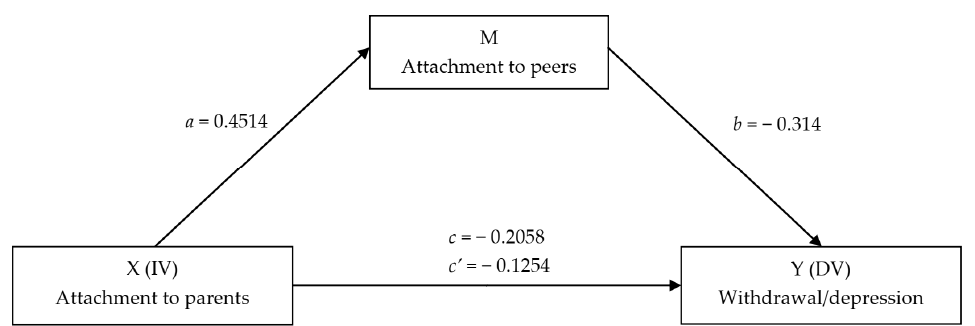
Figure 1. Graphical representation of the mediation model of the effect of the parental attachment security (X) on adolescents’ withdrawal symptoms (Y), as mediated by the security in peer attachment (M).